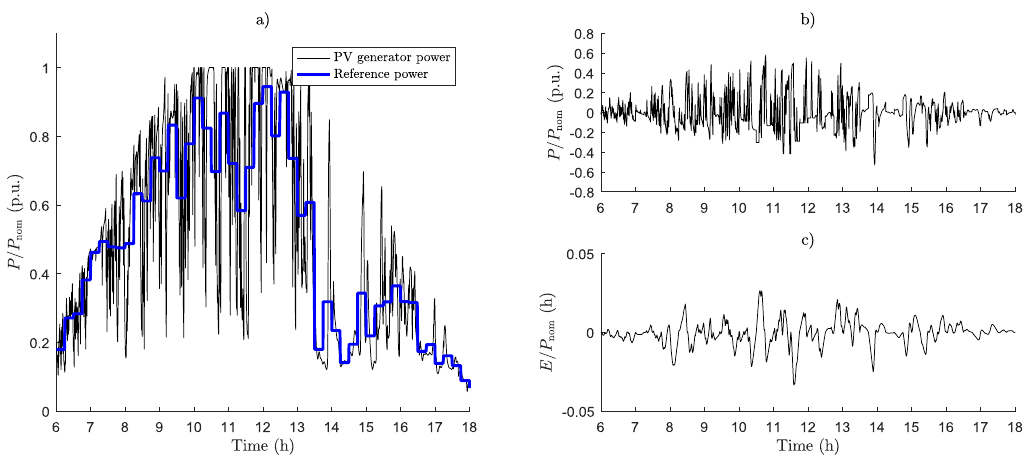
Figure 9. ( a ) 10 MW PV generator power and the grid feeding reference power; ( b ) the corresponding power taken from the ESS and ( c ) the energy stored in ESS (state of charge) with 15 min ISP on 5th of June 2015.